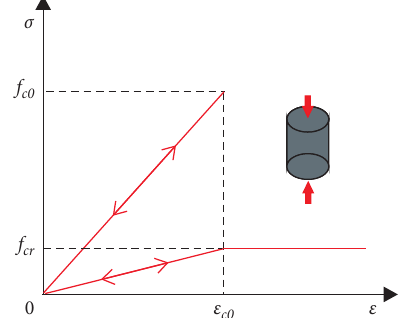
Figure 9: Constitutive relationship of element elastic loss under uniaxial compressive stress.